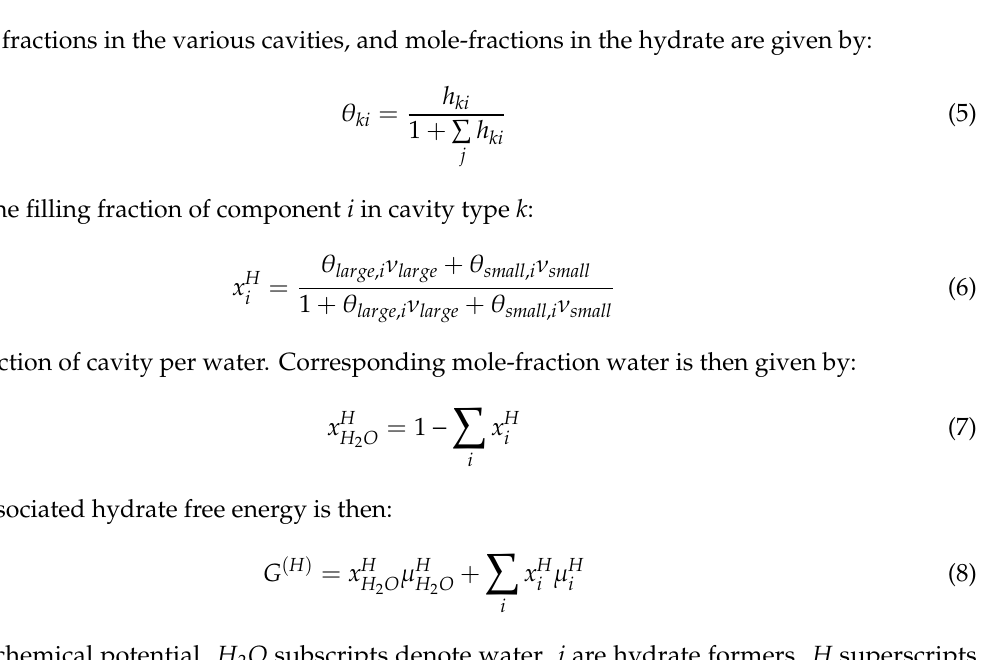
(cid:18) T (cid:19) ( i − 1 ) i = 6 (cid:80) Cj a i T i = 1